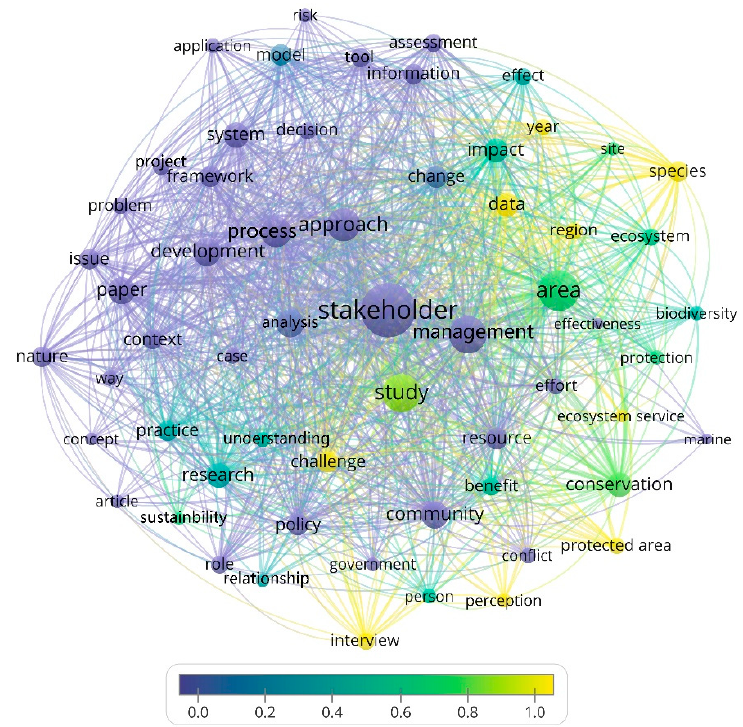
Figure 2. Overlay visualization of the co-occurrence network map of keywords. Keywords are represented based on the average year of publications of documents they occur in, on a color gradient from blue (older publications), to purple (publications equally distributed across the timespan 2000–2021), to yellow (more recent